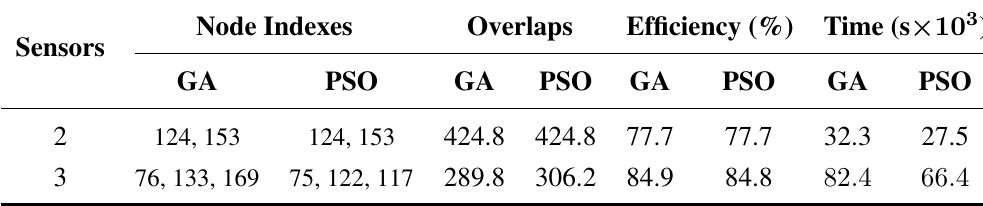
Table 6. Sensor placement in the Limassol WDN using stochastic approaches and a time horizon